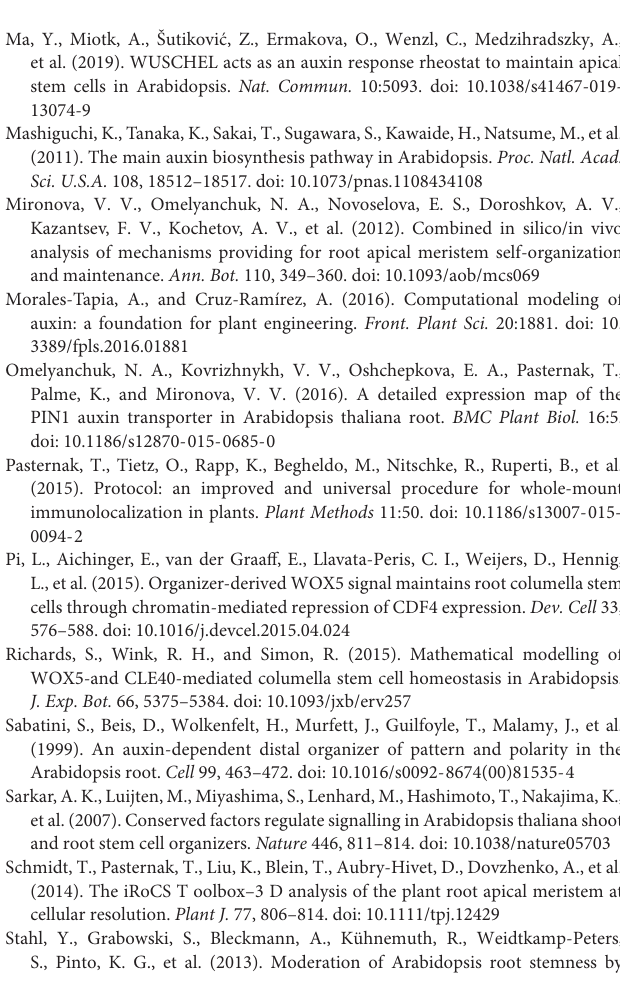
Supplementary Figure 6 | Shortening of the wox5-1 primary root compared to the wild type. The statistical significance of the differences was estimated using Welch’s t -test ( ∗ p < 0.05; ∗∗ p < 0.01; ∗∗∗ p < 0.001). Supplementary Figure 7 | L -Kynurenine partially rescue a portion of DEX-treated 35S:WOX5-GR TAA1:TAA1-GFP plants. (A) Mock-treated plants. (B) TAA1-GFP signal upon 48 h DEX treatment. (C) TAA1-GFP is partially rescued by L -kynurenine plants (66%, N = 20). (D) No rescue occurs in 33% of plants treated by L -kynurenine. The QC location is marked by the red asterisks. The bar scale – 20 µ m. Supplementary Dataset 1 | Exported data from iRoCS Toolbox of three roots for Figure 2 . Supplementary Table 1 | Quantitative analysis of mitotic and S-phase nuclei distributions in 35S:WOX5-GR root tips at 0, 12, and 48 h of DEX incubation. Analysis performed on the root tip models created in iRoCs Toolbox (Schmidt et al., 2014) using 3D confocal images labeled by EdU/DAPI. Supplementary Table 2 | The primers used for qRT-PCR. Supplementary Table 3 | Parameter settings used in the 2D model. Supplementary Table 4 | Cell sizes for the QC and the columella cells used as initial data. Supplementary Table 5 | Parameter settings used in the 1D